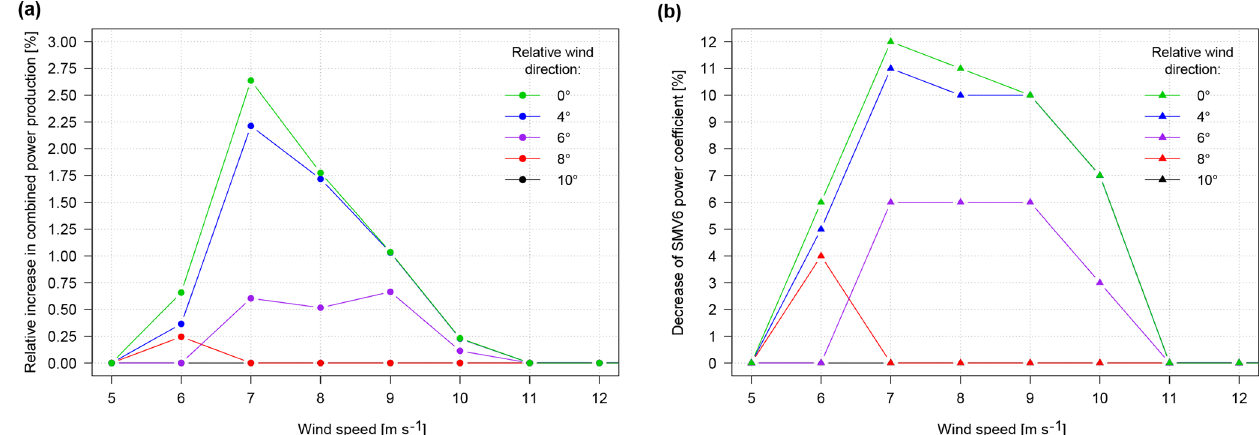
Figure 12. Influence of changing relative wind direction. Variation of power gain (a) and optimal SMV6 c P (b) as a function of wind speed.